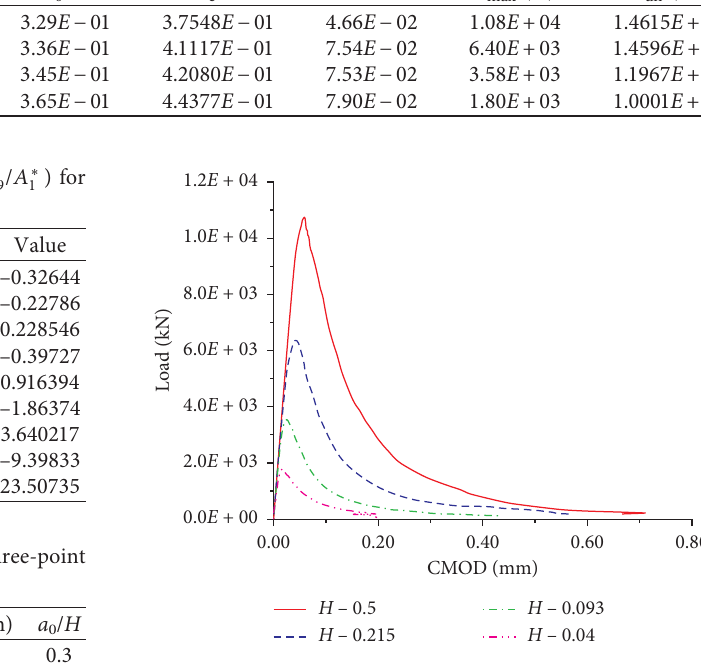
Figure 6: Average response curves of load versus crack mouth opening-displacement (P-CMOD) curves by three-point bending tests on notched beams with α �